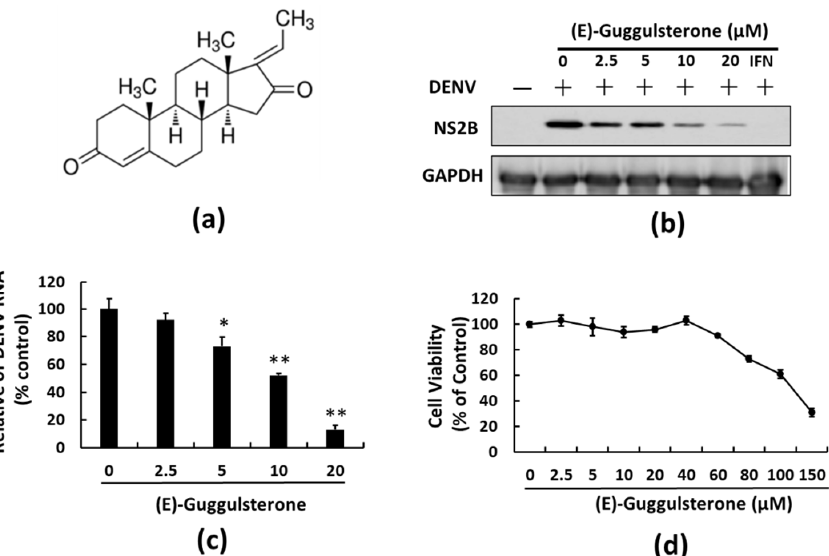
Figure 1. (E)-Guggulsterone inhibits DENV replication in a dose-dependent manner. ( a ) (E)-guggulsterone chemical structure. (E)-guggulsterone efficiently inhibited DENV ( b ) protein synthesis and ( c ) RNA replication in a dose-dependent manner. DENV-infected Huh-7 cells were treated with 0.1% of DMSO (dose 0, consider as the negative control), 2.5, 10, or 20 μ M (E)-guggulsterone for 3 days. The DENV protein and RNA levels were analyzed by Western blotting and RT-qPCR, respectively. The percent inhibition was relative to the cells treated with 0.1% DMSO (corrected to “0”) with DENV infection defined as 100%. ( d ) Cell viability of (E)-guggulsterone. Huh-7 cells were treated with the indicated concentrations of (E)-guggulsterone for 3 days, and the cell viability was assessed using an MTS assay. Error bars denote the mean ± SD of three independent experiments ( n = 3). * p < 0.05; ** p < 0.01.